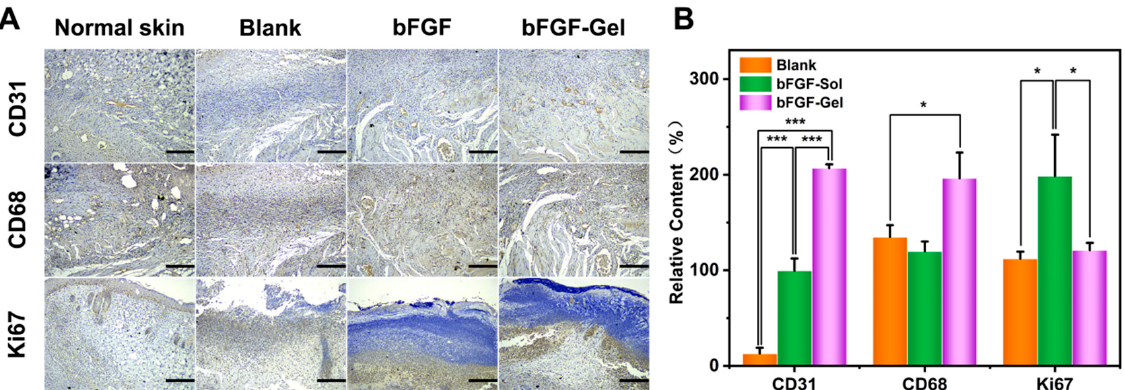
Figure 5. Immunohistochemical analyses of wounds on the dorsum of mice by CD31, CD68, and Ki67 staining after 10 days. ( A ) Representative images of CD31, CD68, and Ki67 staining in groups of Normal skin, Blank, bFDF, and bFGF-Gel at day 10; Scale bar = 200 µ m. ( B ) Semiquantitative results of CD31, CD68, and Ki67 staining. The data were represented as mean ± SD ( n =3). * p < 0.05, *** p < 0.001 . Scale bar = 200 μ m.